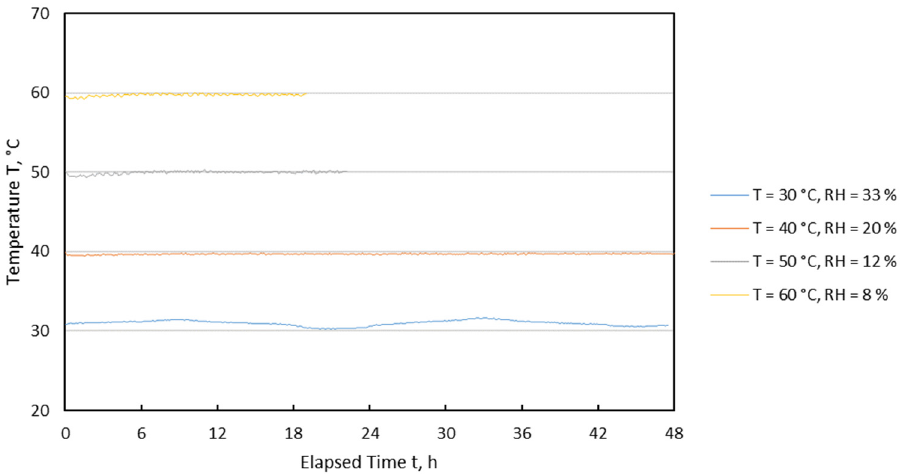
Figure 8. Temperature vs. time; temperature during drying of fresh nettles at different levels of set air temperature (T set ) in the HPD TP3+; x set = 0.01, v set = 0.2 m·s − 1 .